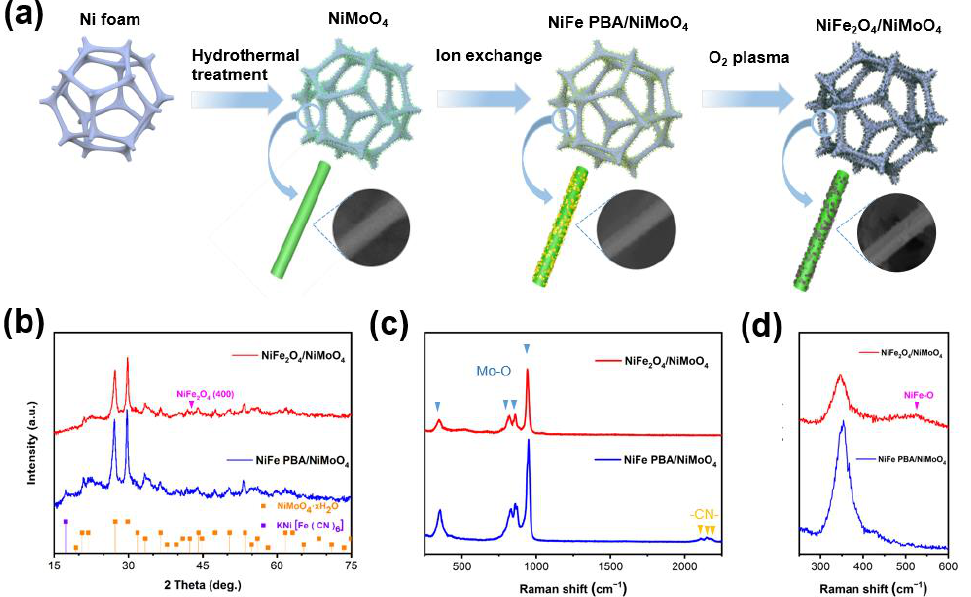
Figure 1. ( a ) Schematic illustration of the synthesis of NiFe 2 O 4 /NiMoO 4 ; ( b ) XRD patterns of NiFe PBA/NiMoO 4 and NiFe 2 O 4 /NiMoO 4 ; ( c ) Raman spectra of NiFe PBA/NiMoO 4 and NiFe 2 O 4 /NiMoO 4 ; and ( d ) Raman spectra of NiFe PBA/NiMoO 4 and NiFe 2 O 4 /NiMoO 4 in a region from 250 cm −1 to 750 cm −1 , respectively.